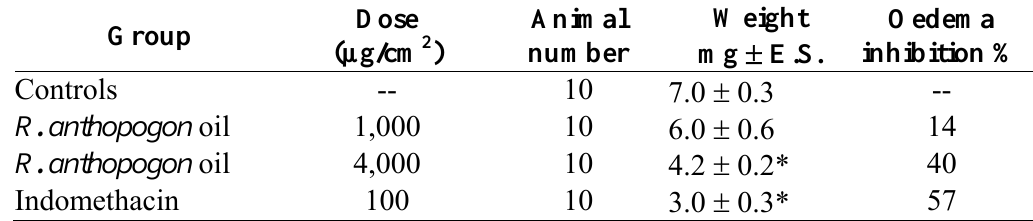
Table 2. The topical anti-inflammatory activity of R. anthopogon essential oil and indomethacin on croton oil induced ear oedema in